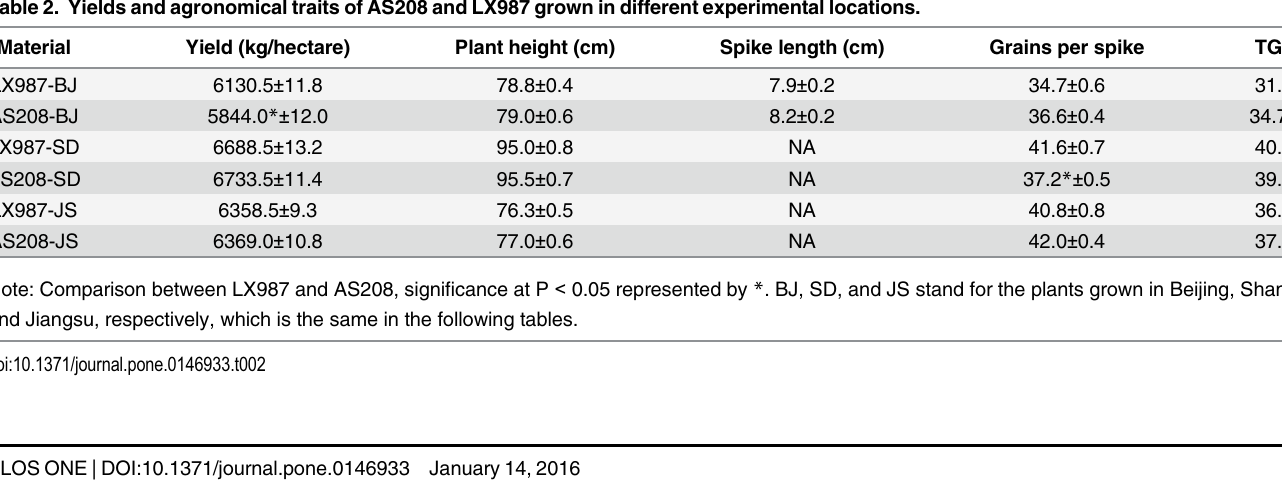
Table 2. Yields and agronomical traits of AS208 and LX987 grown in different experimental locations. Material Yield (kg/hectare) Plant height (cm)